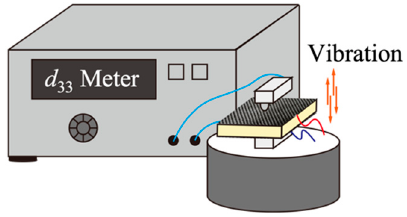
Figure 3. The d 33 measurement equipment.